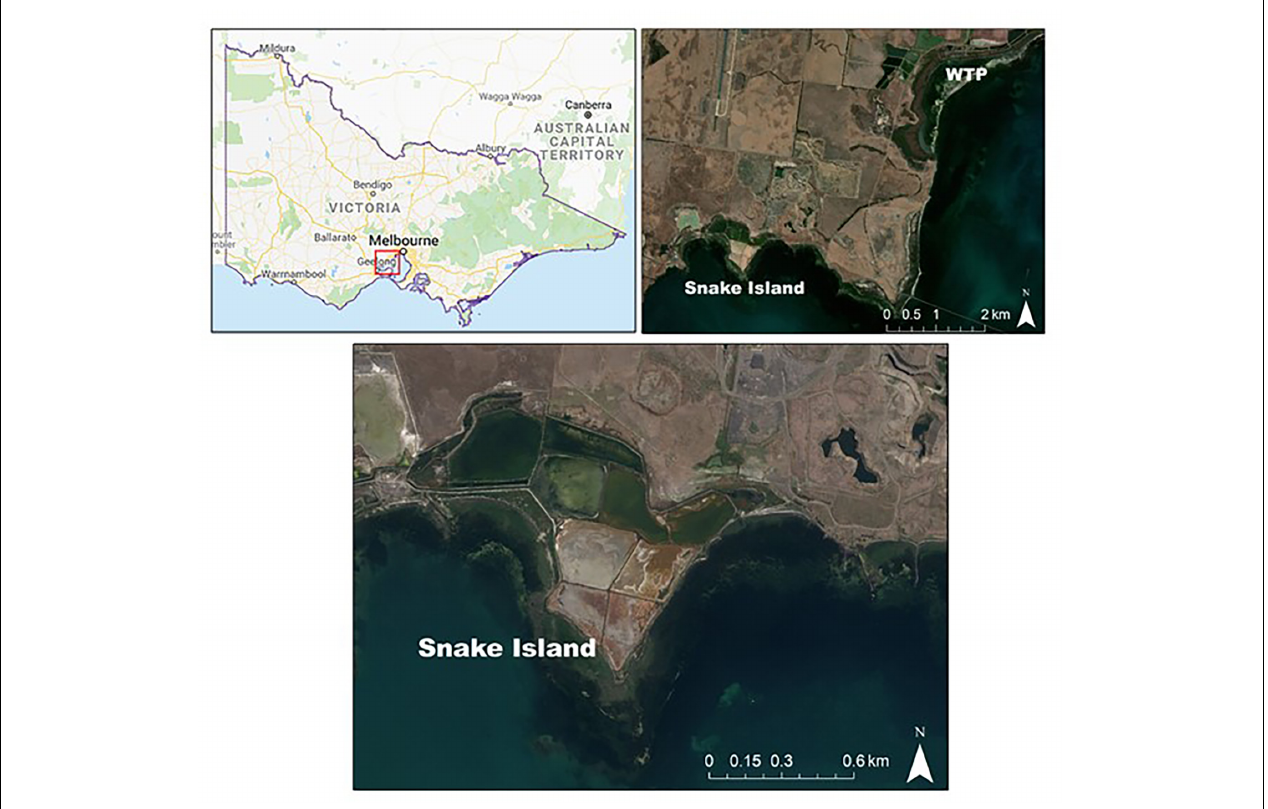
FIGURE 1 | The study sites are located on the western shoreline of Port Phillip Bay, Victoria. The recovered tidal marsh and salt pond sites at Snake Island, Avalon and the recently rehabilitated tidal marsh site, formerly part of the Western Treatment Plant (WTP), Werribee (Map Source: ESRI DigitalGlobe, ArcGis 10.5.1).